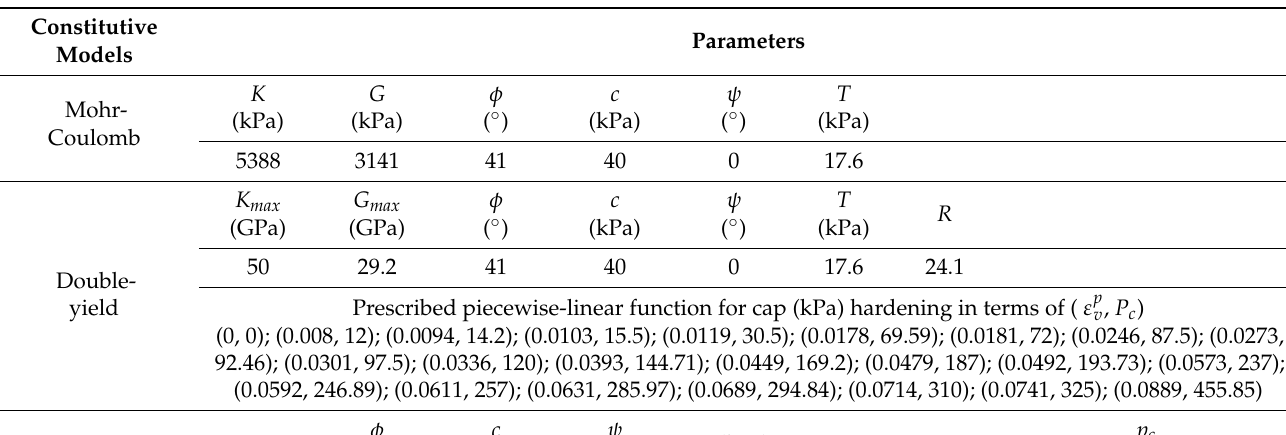
Figure 5. A numerical model of one-dimensional consolidation tests built with FLAC 3D . In the numerical simulations, the Poisson’s ratio of backfill is related to its friction angle through ν = (1 − sin φ )/(2 − sin φ ) by considering a unique value of at-rest earth pressure coefficient K 0 [49,50].The tensile strength T of backfill is taken as 1/10 of its uniaxial compressive strength (UCS) [39]. The initial value of void ratio e ini is calculated based on the measured porosity. However, some parameters remain unknown including K and shear modulus G for the Mohr–Coulomb model, R and the piecewise-linear function of p c for the double-yield model, λ *, κ *, and p c for the Soft Soil model. These parameters are determined by calibrating the numerical results based on part of laboratory results of Pierce [26] associated with the loading paths 1 and 2 as shown in Figure 4. Table 1 summarizes all parameters applied for different constitutive models. Numerical models with the calibrated parameters are then called the calibrated models, which are further applied to predict the other part of laboratory results associated with loading paths 3 and 4. Table 1. Parameters of different constitutive models applied for backfill in numerical simulations of one-dimensional